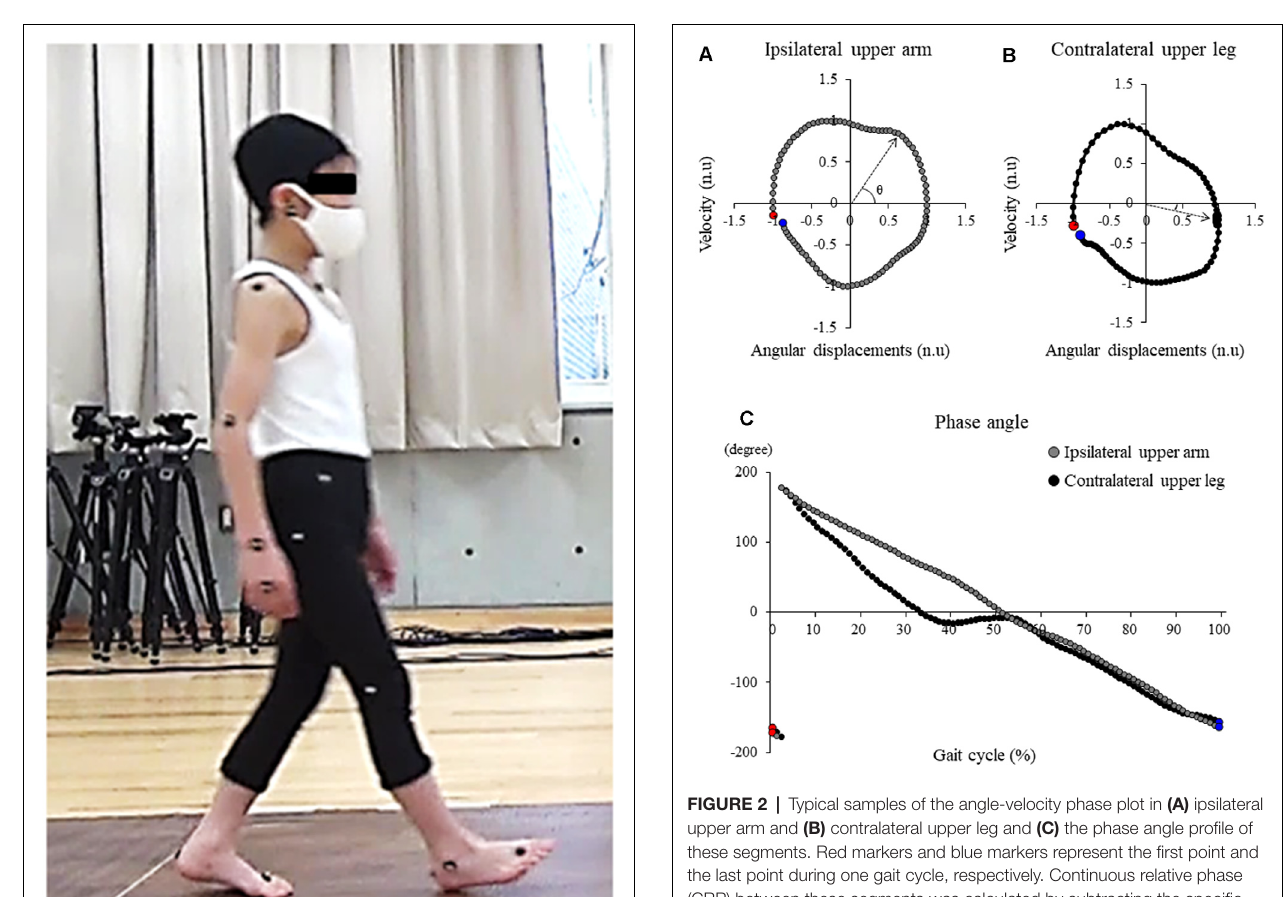
plane (Hof et al., 2005). XCOM is calculated by v XCOM = x + (cid:112) g /